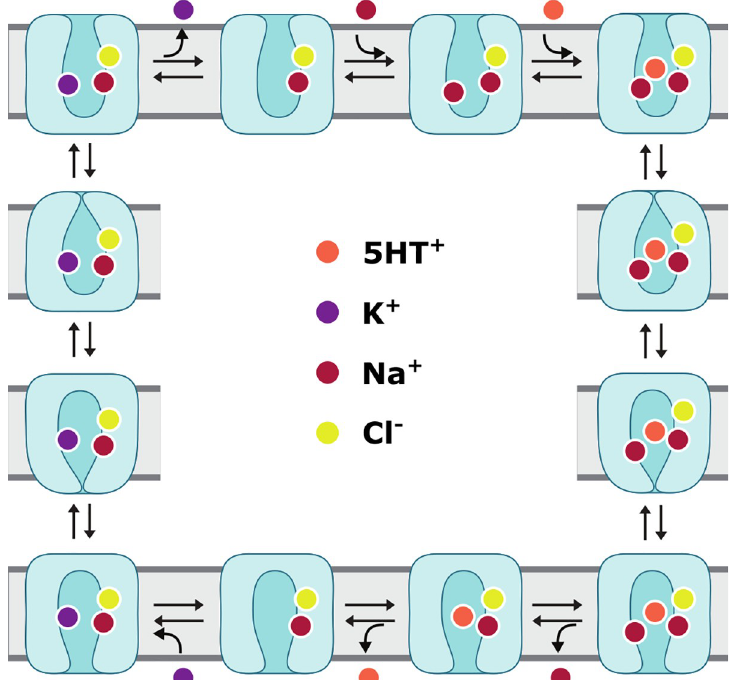
Fig 1. Schematic representation of key steps in the physiological transport cycle of hSERT. The outward-open conformation of hSERT bound to Na + and Cl − is entered by a second Na + ion and the endogenous substrate 5HT + . Once all these required components are bound, the extracellular gates can close, allowing the transporter to undergo progressive conformational changes through the outward-occluded, fully-occluded, and inward-occluded transporter states. Once the inward-open state is reached, one Na + ion and 5HT + are released into the cytosol. Upon binding of a K + ion, the transporter resets via equivalent conformational changes, but in reverse order, finishing its cycle by release of K + into the synaptic cleft.